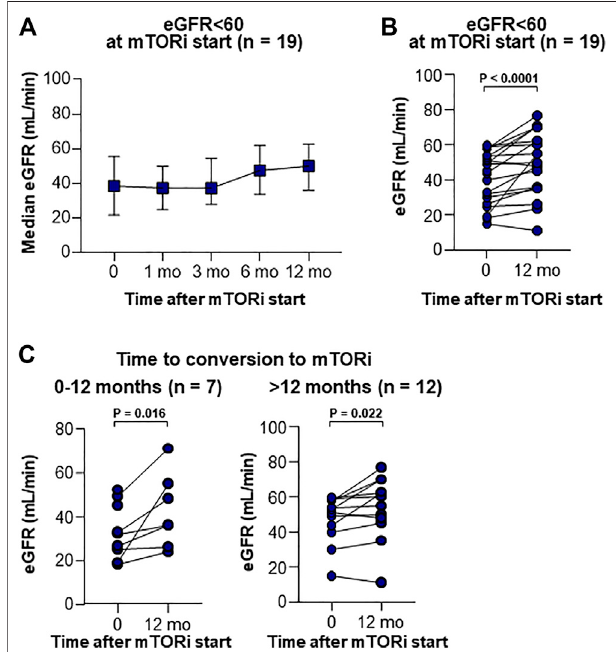
FIGURE4| SerialrenalfunctionsinCKDpatientsaftertheintroductionof mTOR inhibitors. (A) Serial median with IQR of GFR level in patients < 60 ml/ min. (B) Changes of GFR in CKD patients between at the start and at 12 months after the introduction of mTOR inhibitors. Wilcoxon ’ s test was used for comparing GFR between baseline and 12 months after mTOR inhibitorstart. (C) ChangesofGFRinCKDpatientsbetweenatthestartandat 12 months after the introduction of mTOR inhibitors according to the time from LT tomTOR inhibitor start.Wilcoxon ’ stest wasused forcomparing GFR between baseline and 12 months after mTOR inhibitor